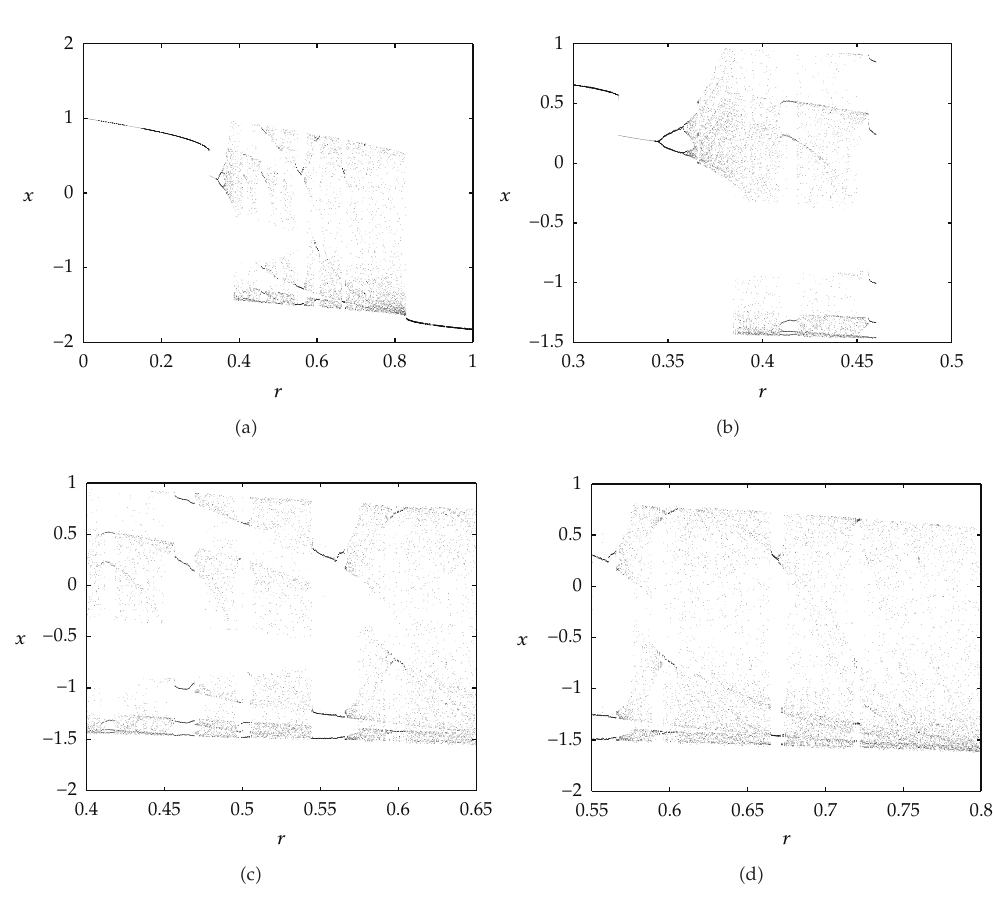
Figure 3: (cid:6) a (cid:7) Bifurcation diagram of the system (cid:6) 1.3 (cid:7) in (cid:6) r,x (cid:7) plane for A (cid:8) 1, B (cid:8) 1, δ (cid:8) 0 . 5, ω (cid:8) 1, r 1 (cid:8) 0 . 01, and r 2 (cid:8) 0 . 001. (cid:6) b, c, and d (cid:7) Amplified bifurcation diagram of Figure 3 (cid:6) a (cid:7) : (cid:6) b (cid:7) 0 . 30 (cid:2) r (cid:2) 0 . 50; (cid:6) c (cid:7) 0 . 40 (cid:2) r (cid:2) 0 . 65; (cid:6) d (cid:7) 0 . 55 (cid:2) r (cid:2) 0 . 80.